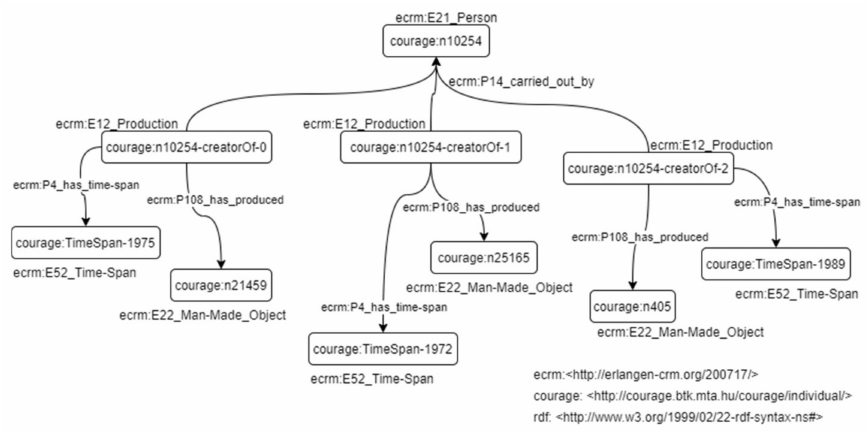
Figure 5. CreatorOf representation in CIDOC-CRM. The owner role is represented by the E8 Acquisition class in contrast to other roles. Ownership of an item in COURAGE can be transferred to multiple people and organiza- tions during that time (see Figure 6).